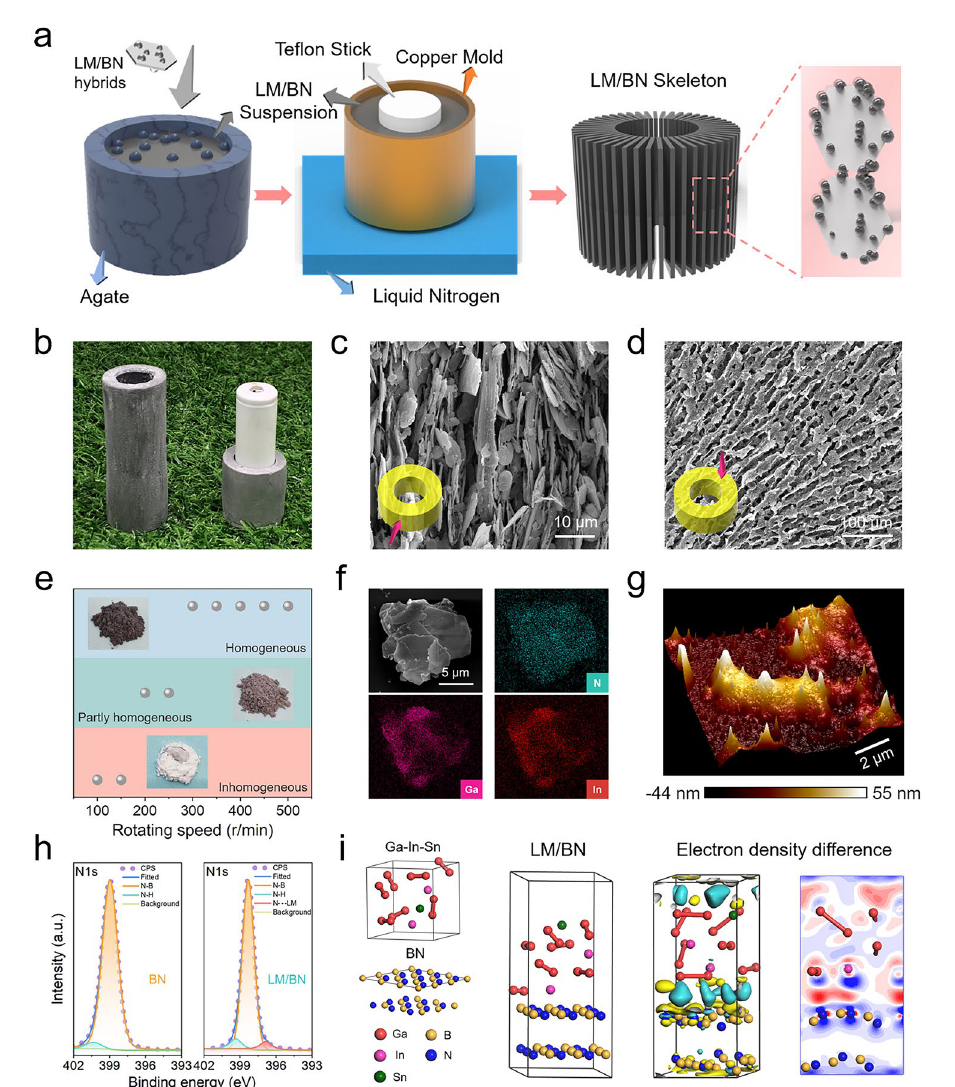
Fig. 2 a Schematic of the preparation process for the LM/BN skeleton with radially oriented thermal pathways. b Digital photograph of the PEG/LM/BN PCM thermal regulator which is conformable to the structure of a 18,650 LIB. c Scanning electronic macroscopy (SEM) images showing longitudinal and d cross-sectional morphology of the thermal regulator made of PEG/LM/BN composite. e Morphological variation of LM/BN binary hybrids with the increasement of ball-milling speed which could offer larger mechanical force. The pink region manifests the phase separation. The green region manifests the formation of the partly homogeneous phase. The blue region indicates the complete formation of the homogeneous phase. f SEM element mapping result of the LM/BN hybrid filler proving successful modification of the pure BN sheets by LM. g Three-dimensional height image of the LM/BN hybrid filler from atomic force microscopy result. h X-ray photoelectron spectroscopy N 1 s spectra of BN (left) and LM/BN hybrid filler (right). i Density functional theory models and difference charge density image of BN approach- ing LM. In the three-dimensional image, the yellow region represents electron loss and the blue color represents electron aggregation. The two- dimensional image is from a cross section of the three-dimensional image and the blue color represents electron loss and the red color represents electron